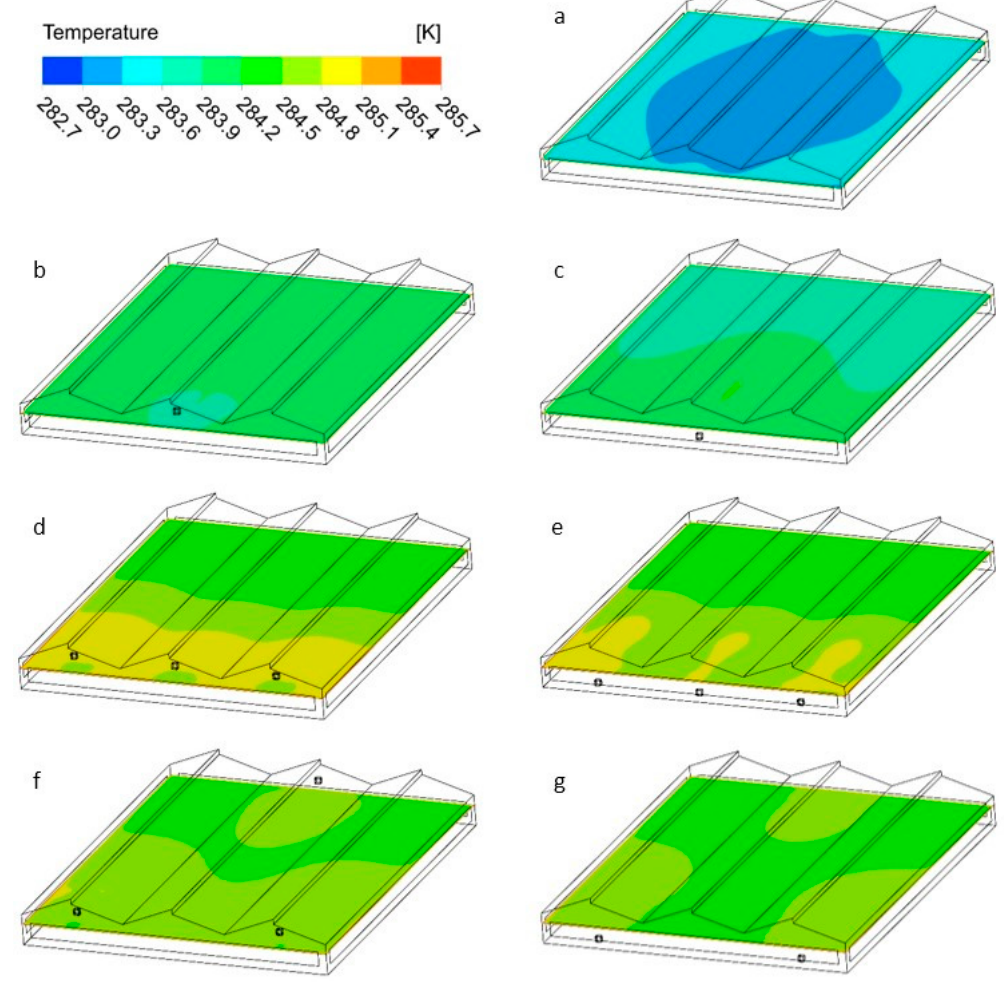
Figure 5. Distribution of temperature (K) at 2 m above the ground in the greenhouse under the initial conditions of the heating computational model in the ( a )–( g ) sceneries of simulation.